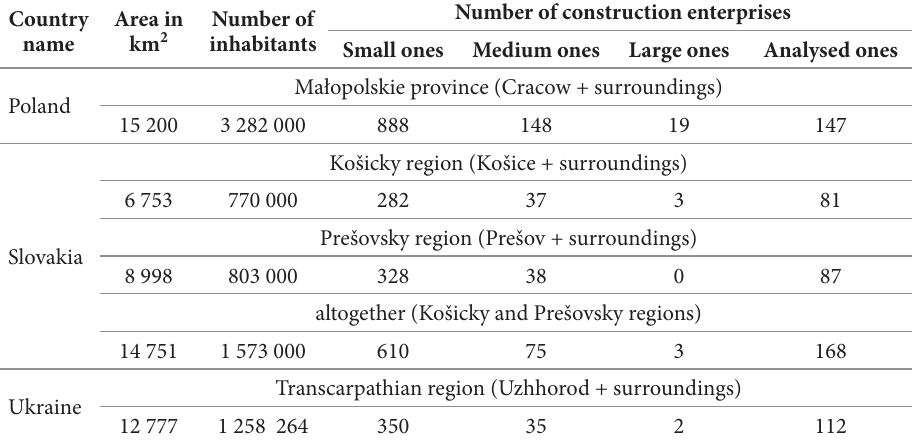
Table 2. Statistical data concerning research done in 2008. The Author’s own study based on data obtained from statistical offices in particular countries and on information from construction industry